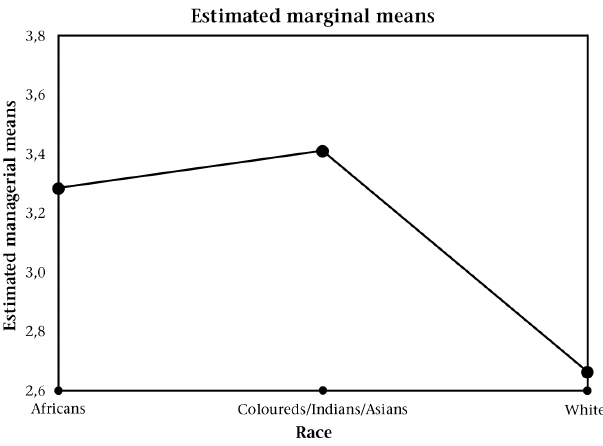
Figure 6: Biographical variable: Race as predictor of the perceptions of black economic